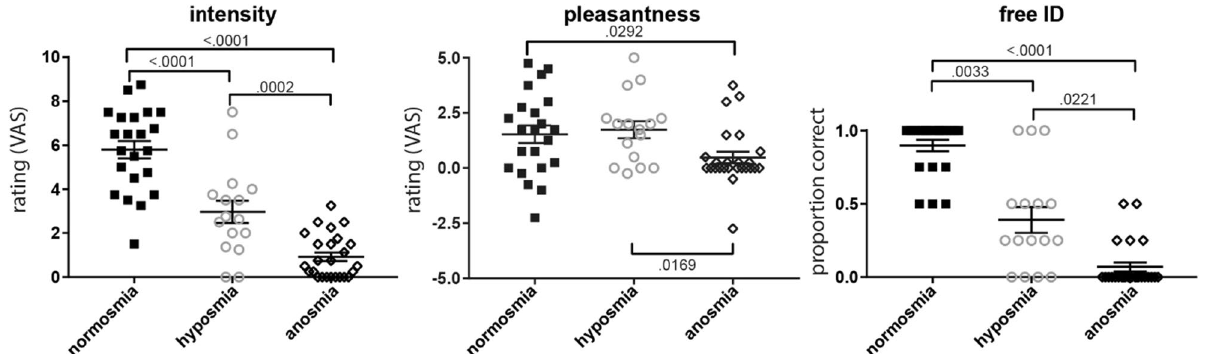
Figure 3. Perceived intensity (left panel), pleasantness (center), and free identification (right) of odors by group. Legend details as in Fig.